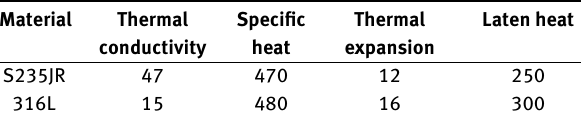
Table 2: Basic thermo physical properties of welded